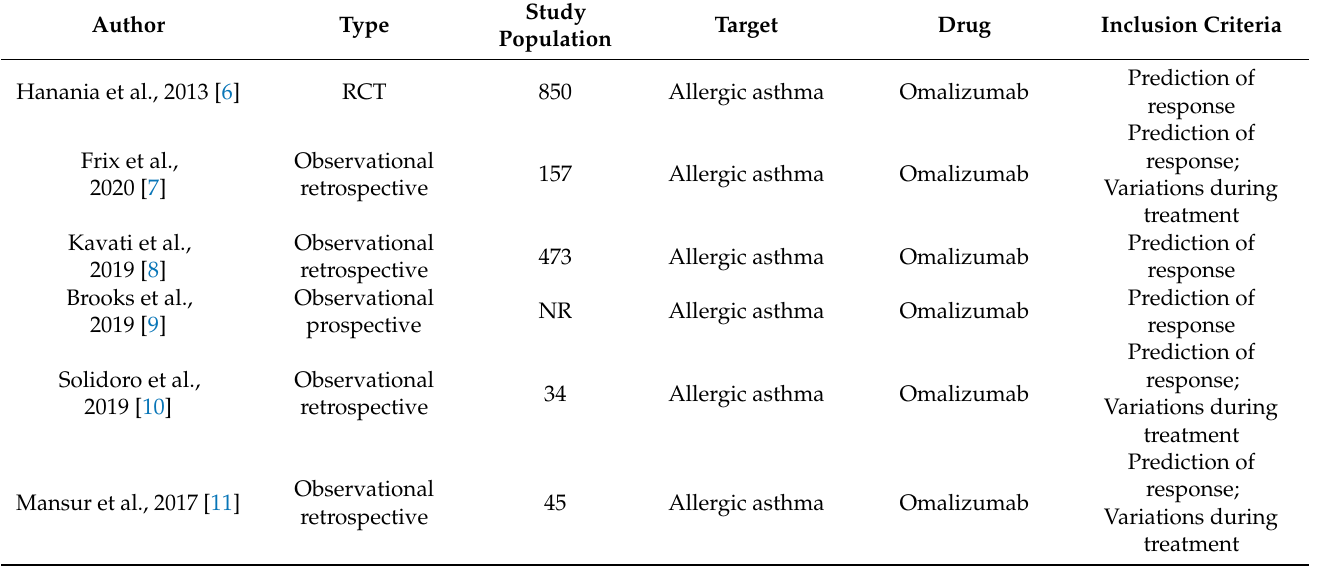
Table 2. List of articles included in the